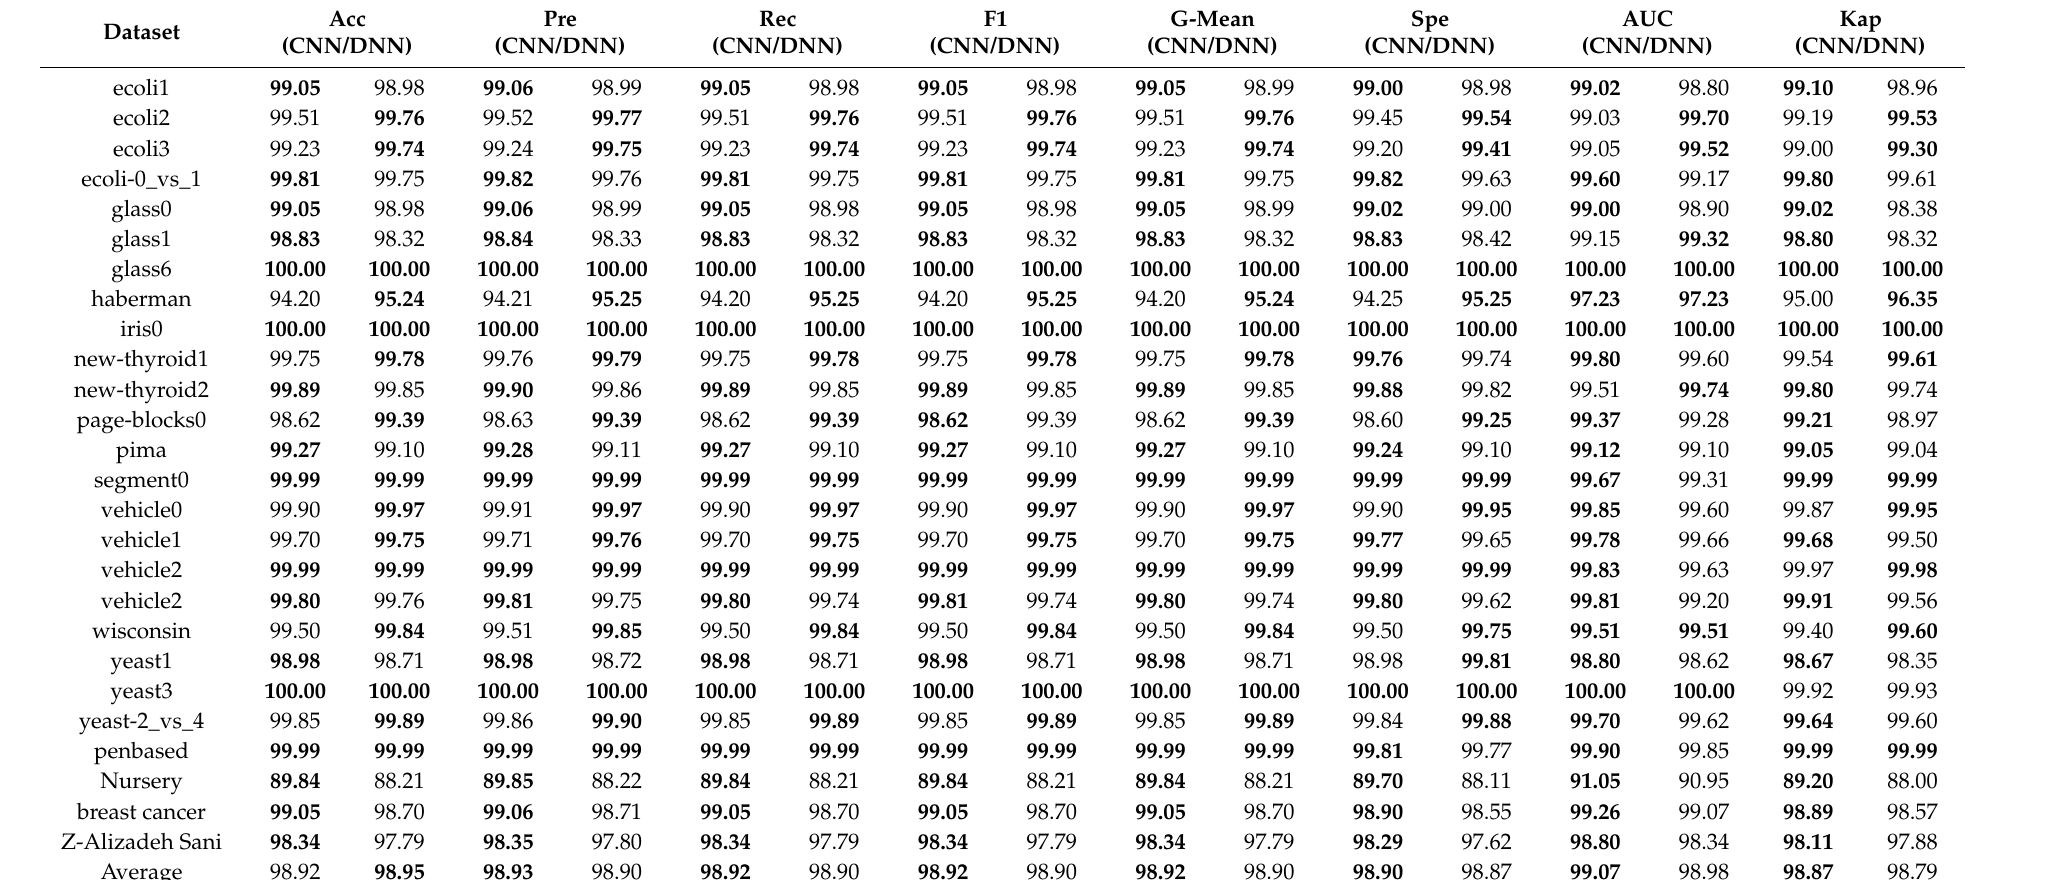
Table 7. TL + NORM. +